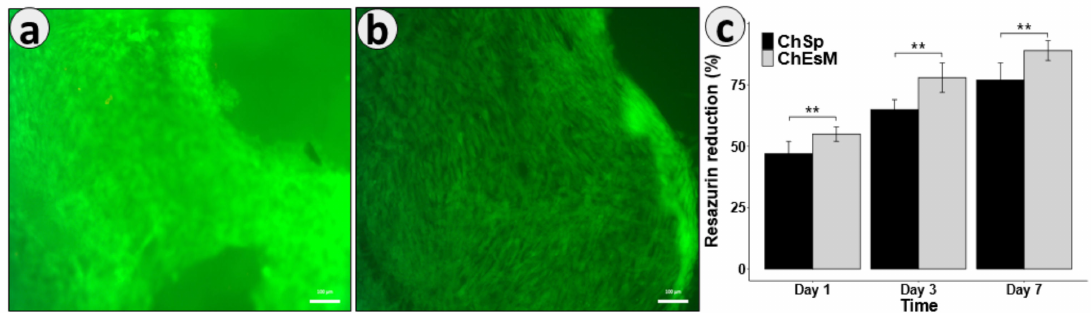
Figure 5. ChSp ( a ) and ChEsM ( b ) live/dead staining with FDA/PI after 48 h of cell cultivation and cell viability ChSp and ChEsM, using Resazurin reduction assay ( c ); **—the significant difference ( p ≤ 0.001) between two groups at the same timepoint.